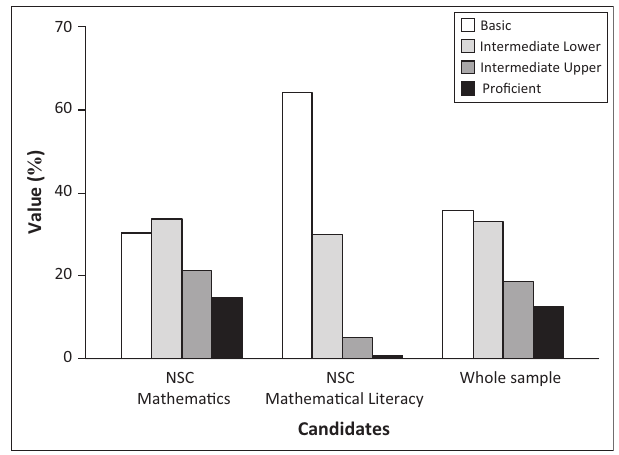
FIGURE 2: Percentage distribution of National Benchmark Test quantitative literacy scores by proficiency category for the whole sample, National Senior Certificate Mathematics and Mathematical Literacy